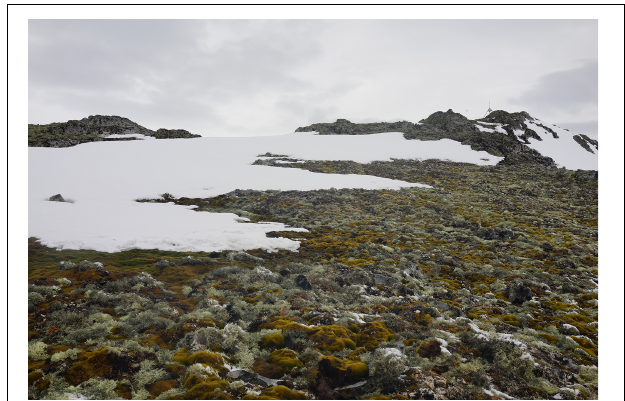
FIGURE 1 | The field picture of Antarctic moss sampling